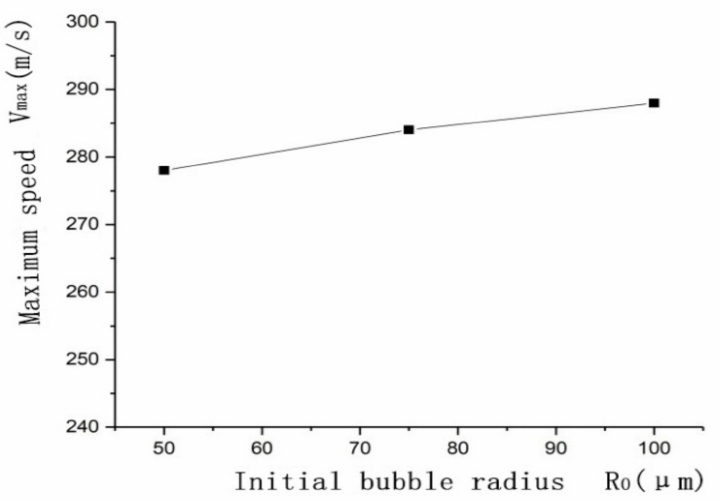
Figure 5. The effect of the ultrasonic frequency on the maximum velocity of the cavitation bubble